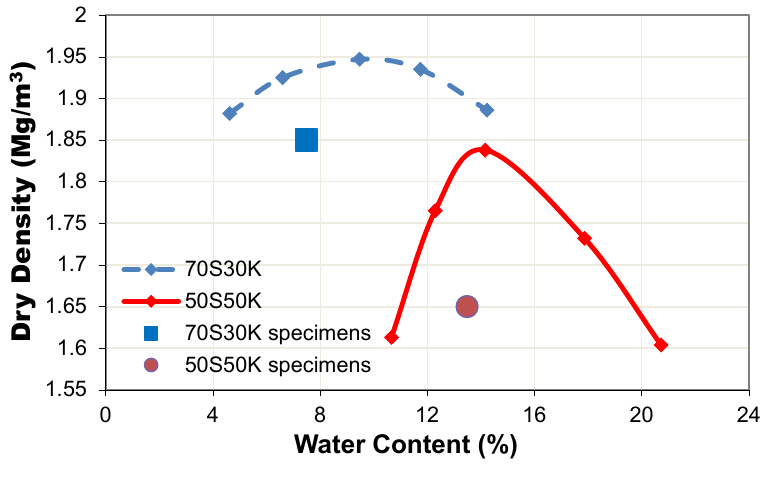
Figure 2. Compaction curve.